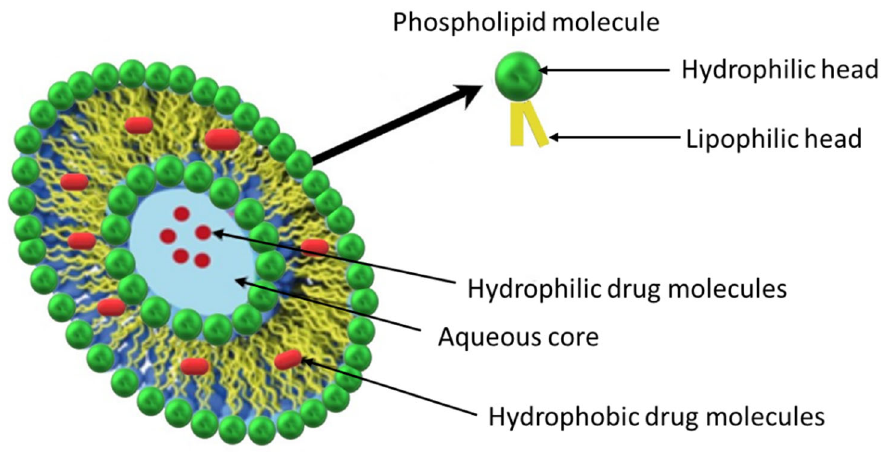
Figure 1. Sketch of liposome